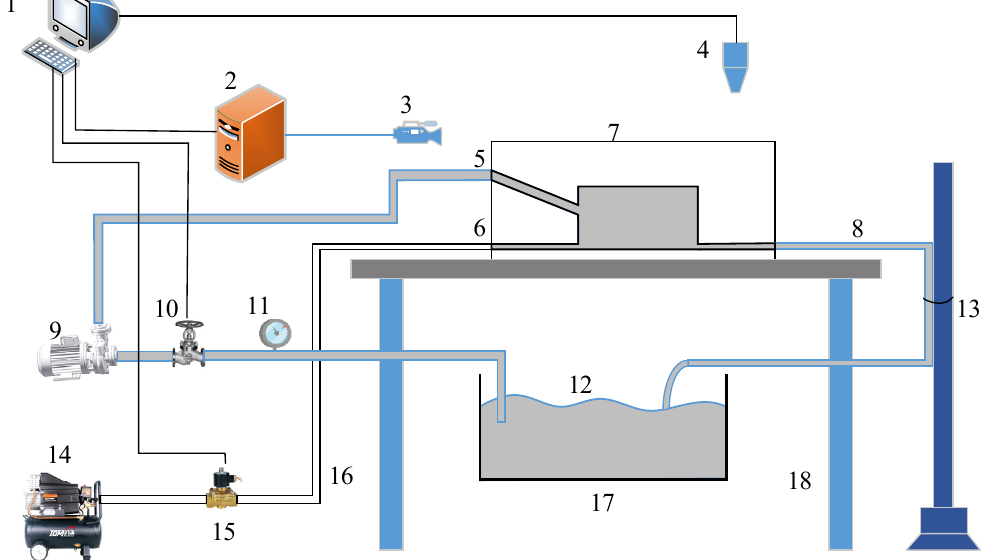
Figure 15. The schematic diagram of the PIV experimental observation platform: 1. control system, 2. particle image velocimetry system, 3. CCD camera, 4. laser generator, 5. abrasive flow inlet, 6. bubble inlet, 7. transparent channel, 8. hosepipe, 9. water pump, 10. throttle valve, 11. pressure gage, 12.